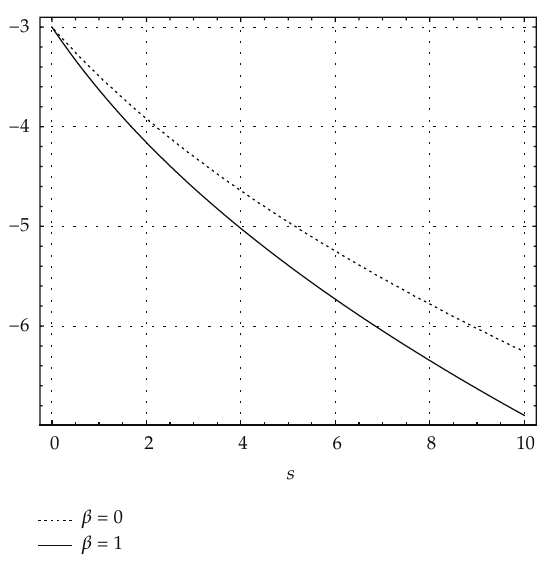
Figure 4: The skin friction (cid:3) f (cid:2)(cid:2) (cid:3) 1 (cid:4)(cid:4) for the axisymmetric and two-dimensional